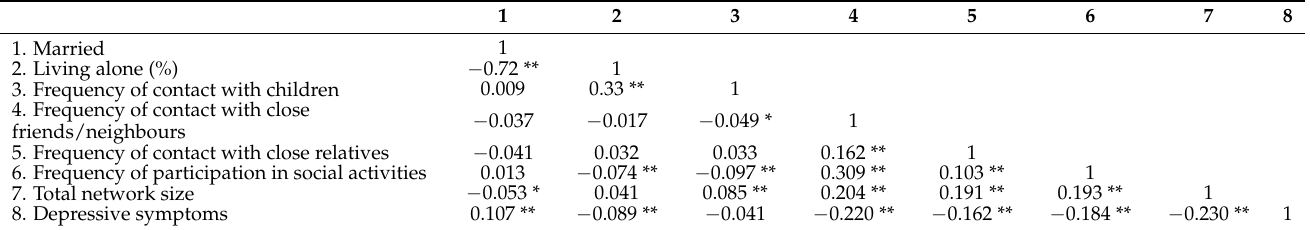
Table 2. Intercorrelation of social network profile variables and depressive